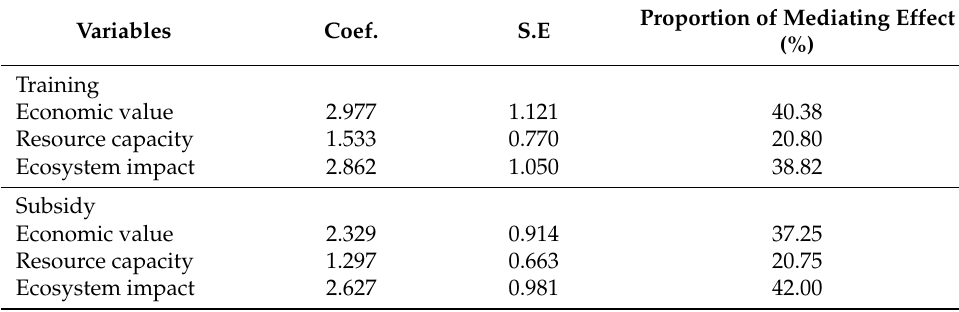
Table 5. The decomposed mediating effect of farmers’ cognition in different policy